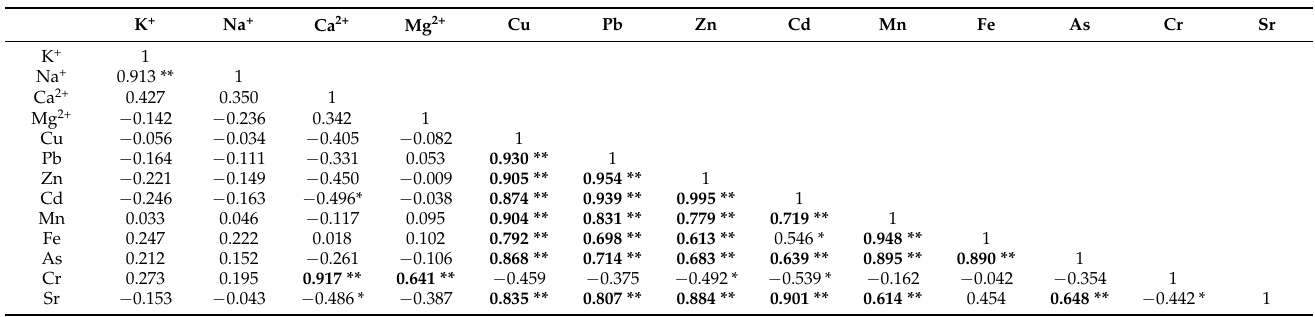
Table 2. The correlation analysis of dissolved heavy metals in the study area.